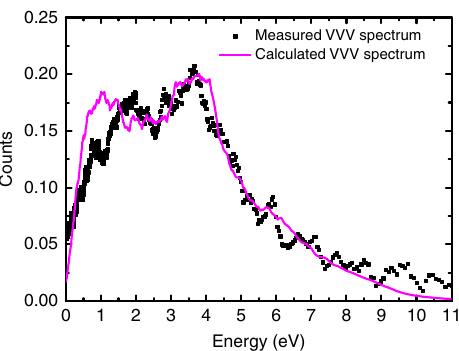
Figure 4 | Experimental and calculated VVV Auger